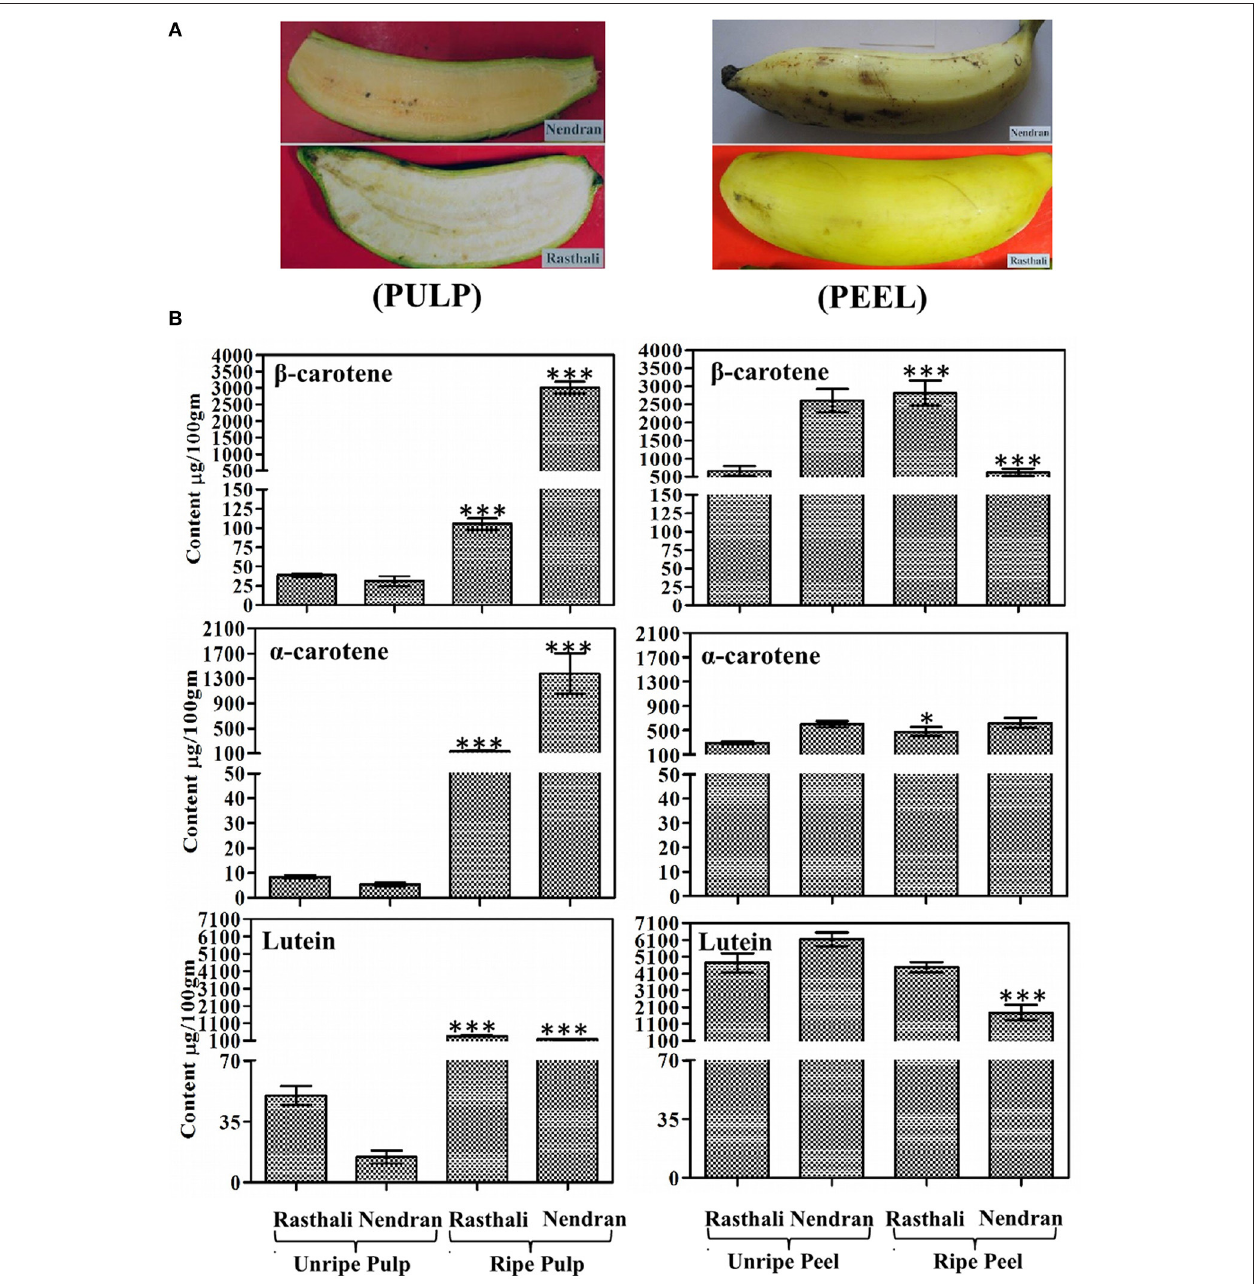
FIGURE 1 | Qualitative and quantitative assessment of carotenoids in fruit tissues of Nendran and Rasthali banana cultivars. (A) Visual observation of ripe fruit-pulp and -peel. (B) Carotenoid profiling in ripe and unripe fruit tissues. Bars denote mean of carotenoid content ± SD. Compounds were quantified by separating extracts from the peel and pulp using HPLC. HPLC chromatograms are given in Supplementary Figures S2 , S3 . Statistical analysis was performed using Student’s paired t -test. Statistical significance was checked at P ≤ 0.05–0.001 (* P ≤ 0.05; *** P ≤ 0.0001) with respect to the unripe- versus ripe-pulp/peel of Rasthali and